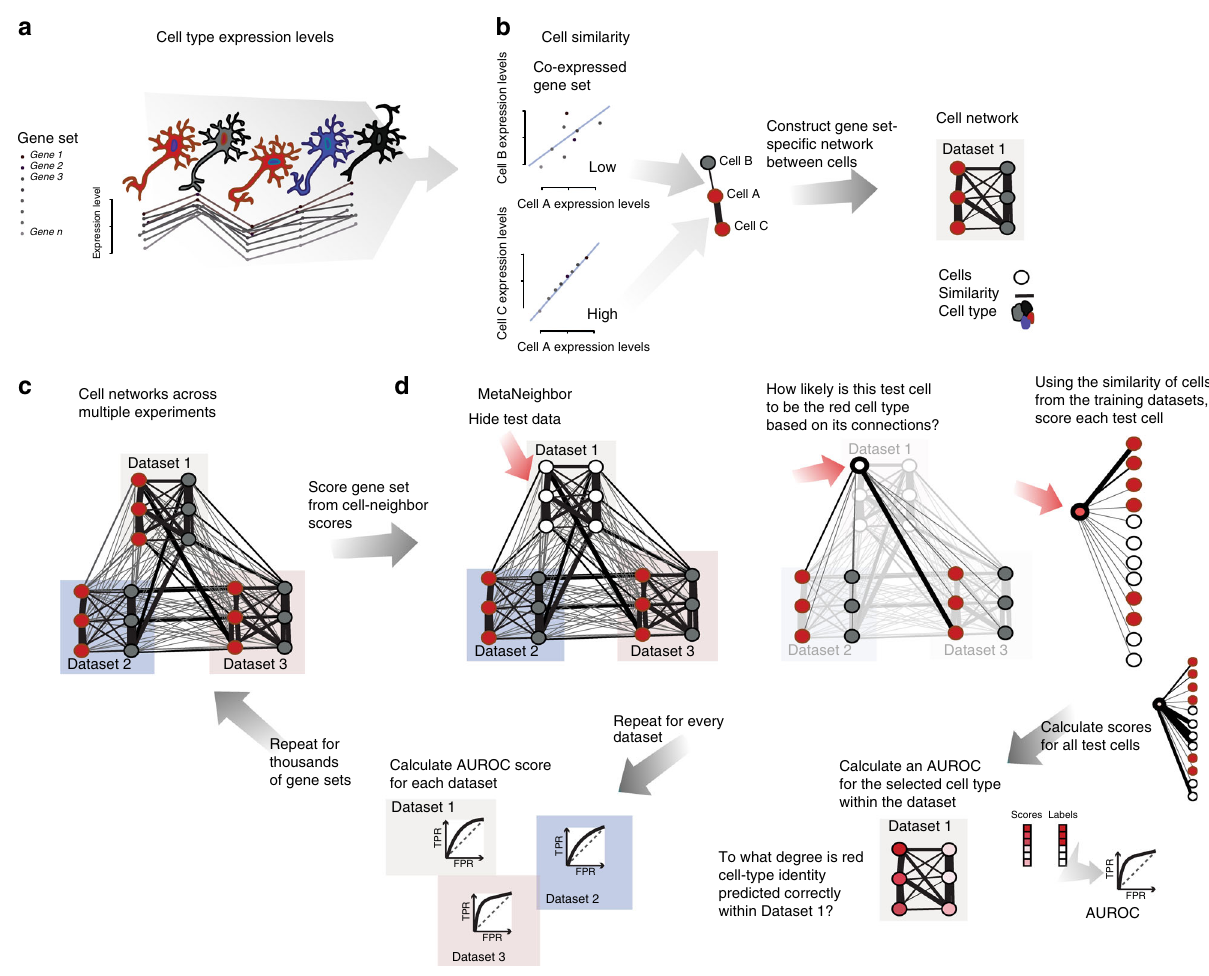
Fig. 1 MetaNeighbor quanti fi es cell-type identity across experiments. a Schematic representation of gene set co-expression across individual cells. Cell types are indicated by their color. b Similarity between cells is measured by taking the correlation of gene set expression between individual cells. On the top left of the panel, gene set expression between two cells, A and B, is plotted. There is a weak correlation between these cells. On the bottom left of the panel we see the correlation between cells A and C, which are strongly correlated. By taking the correlations between all pairs of cells we can build a cell network (right), where every node is a cell and the edges represent how similar each cell is to each other cell. c The cell network that was generated in b can be extended to include data from multiple experiments (multiple datasets). The generation of this multi-dataset network is the fi rst step of MetaNeighbor. d The cross-validation and scoring scheme of MetaNeighbor is demonstrated in this panel. To assess cell-type identity across experiments we use neighbor voting in cross-validation, systematically hiding the labels from one dataset at a time for testing. Cells within the test set are predicted as similar to the cell types from other training sets using a neighbor-voting formalism. Whether these scores prioritize cells as the correct type within the dataset determines the performance, expressed as the AUROC. In other words, comparative assessment of cells occurs only within a dataset, but is based only on training information from outside that dataset. This is then repeated for all gene sets of